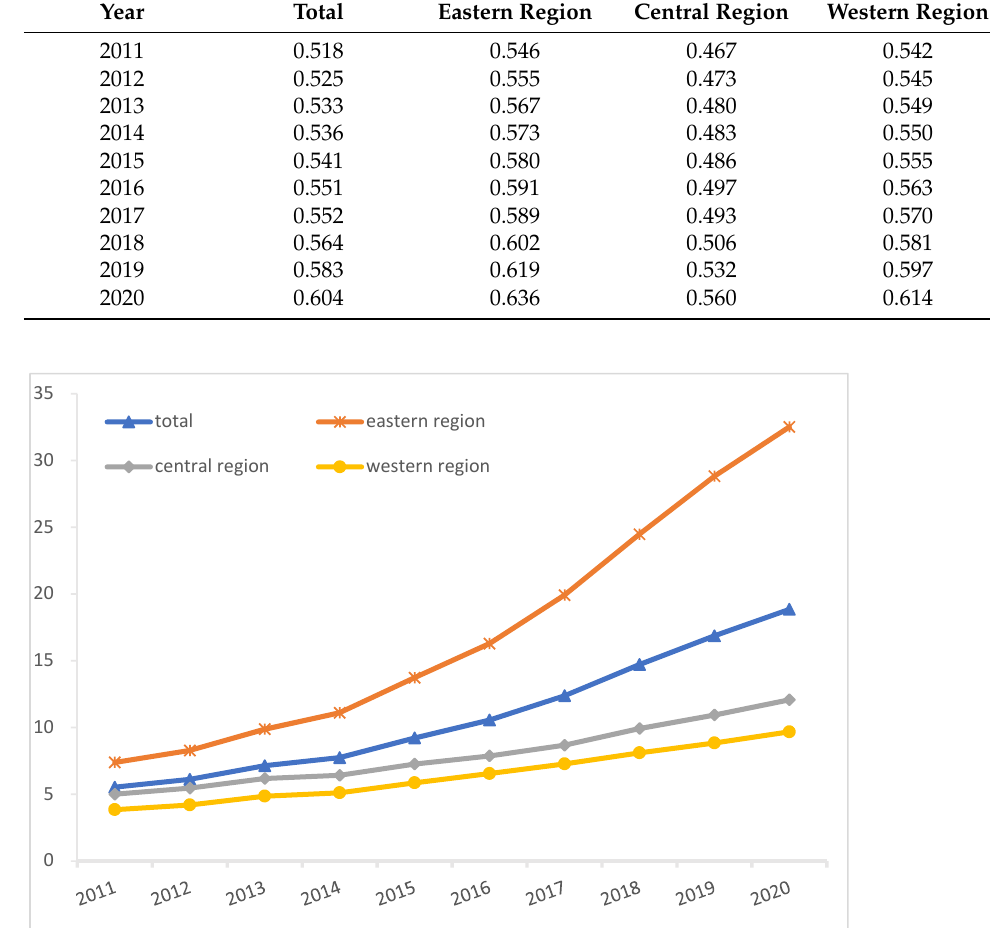
Table 4. Average development level of green agriculture in China from 2011 to 2020.